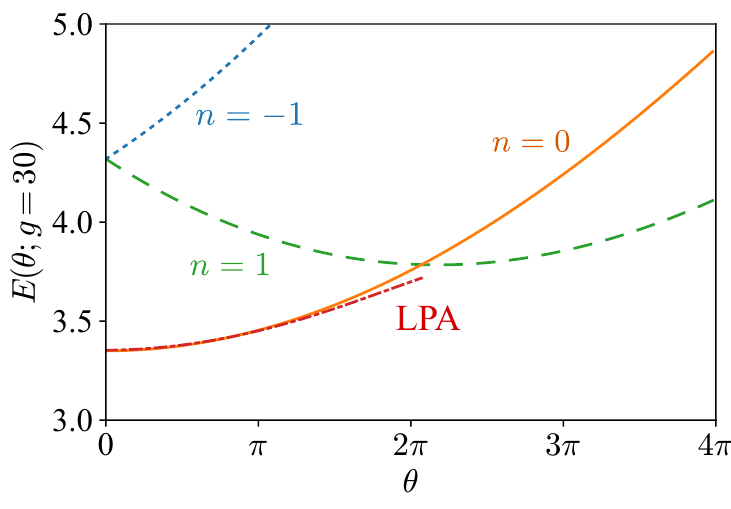
Figure 4 . Eigenenergies E n ( θ ; g ) at g = 30 as functions of θ . The dot-dashed curve represents the fRG results in the LPA. The energy is not shifted here.